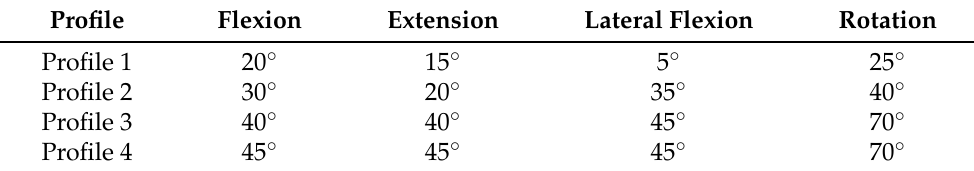
Table 2. ROM of the preset